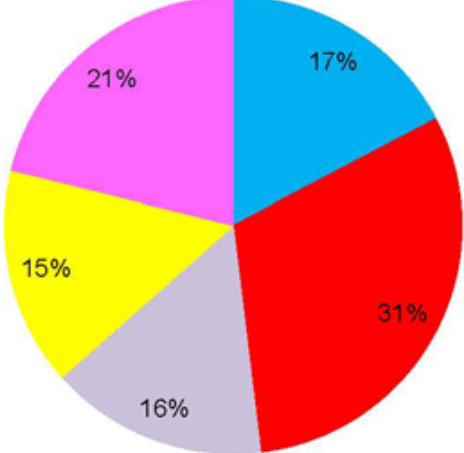
Figure 13: Activity types (by overarching group) predominantly concerned with research use and the mechanisms used (shown as